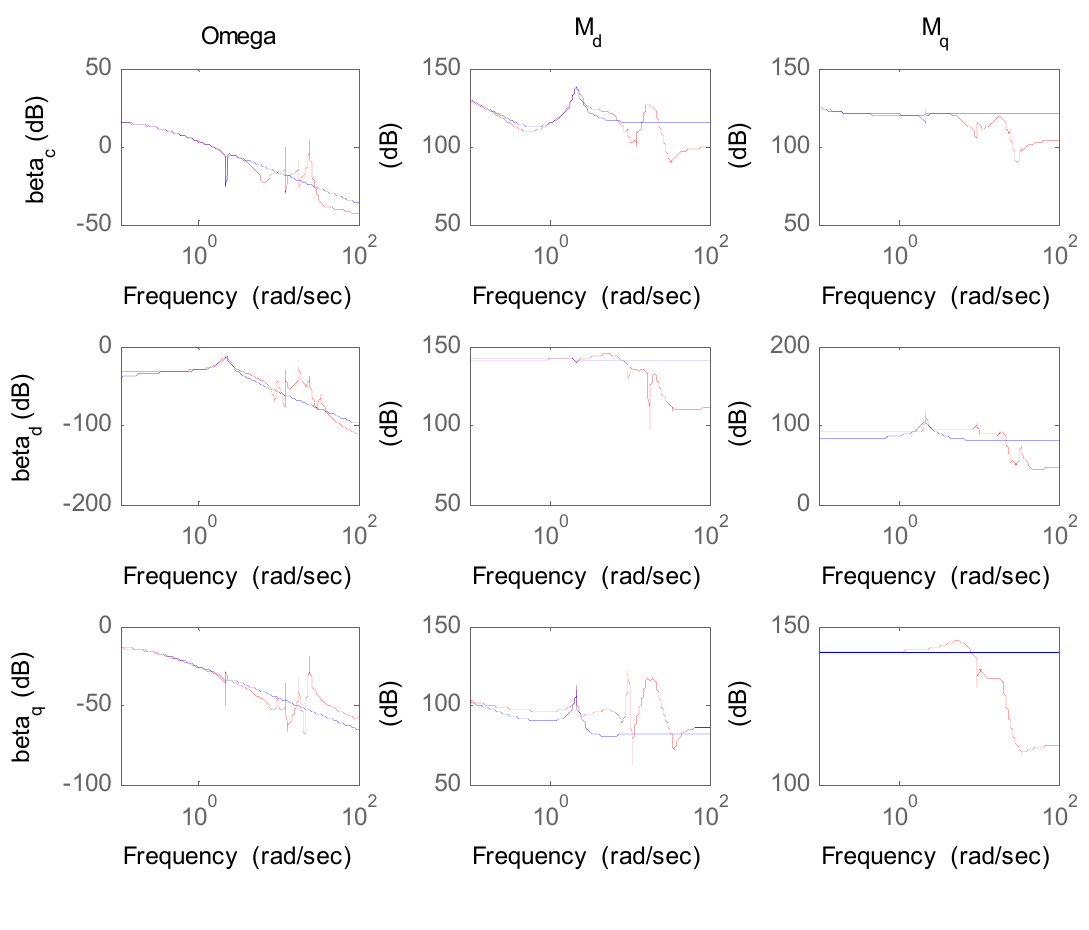
Figure 3. Frequency response from Coleman-transformed pitch angles to rotor speed, d- and q-axis blade moments, both for the high fidelity (red) and the simple models